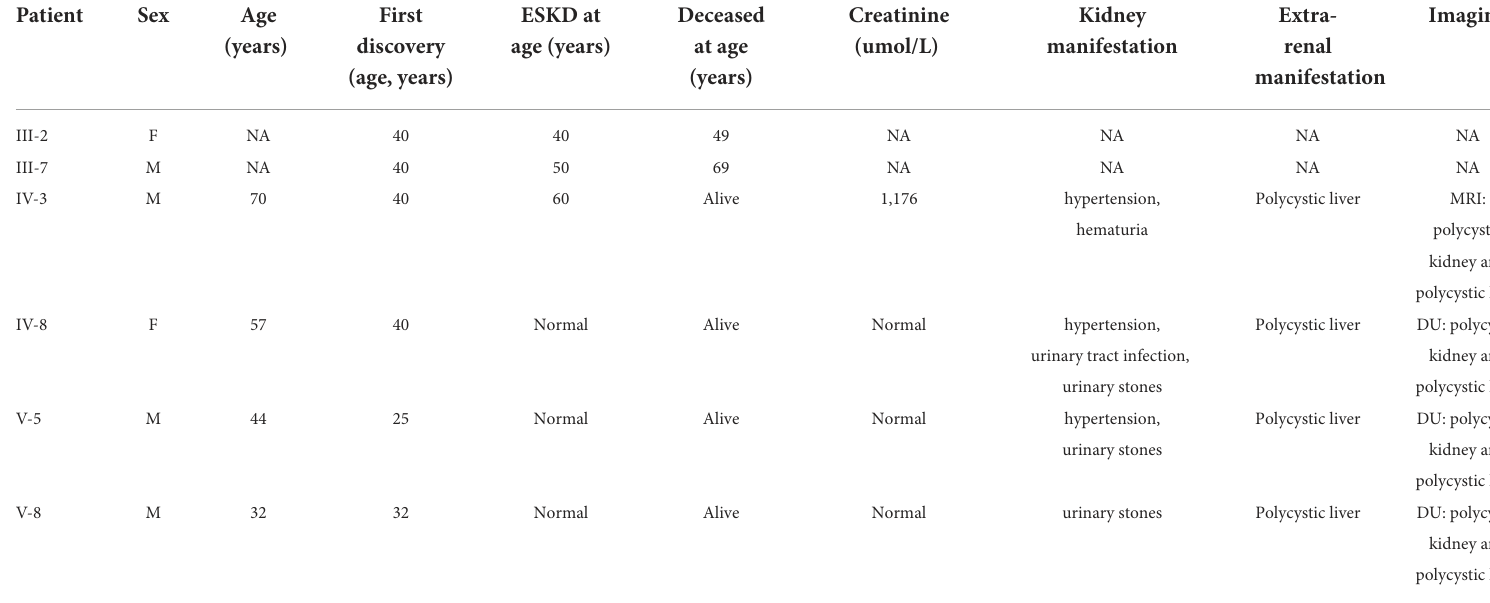
TABLE 2 Clinical and genetic features of six ADPKD